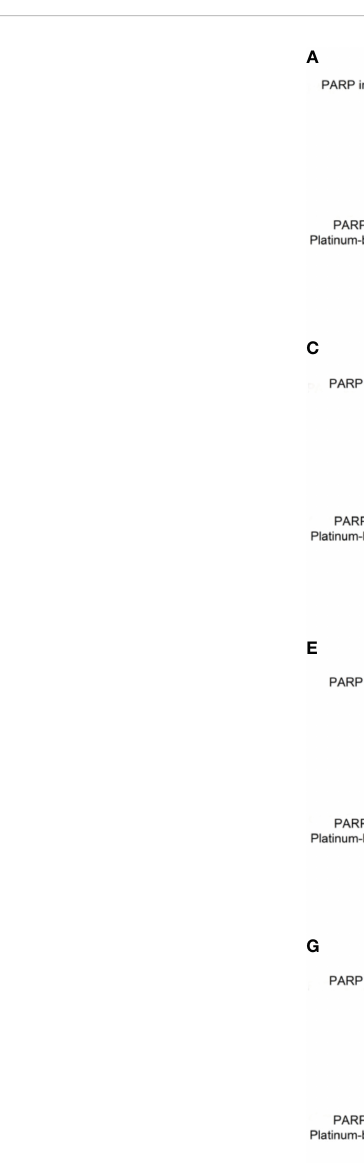
FIGURE 2 Network plots of direct comparisons for ORR (A) , 3-month PFS (B) , 12-month PFS (C) , 24-month PFS (D) , 3-month OS (E) , 12-month OS (F) , 24-month OS (G) , and 36-month OS (H) Each node represents a treatment regimen. The thickness of the lines is related to the number of randomized trials that included relevant direct comparisons, and the size of the nodes is proportional to the number of individuals allocated to the corresponding intervention group.